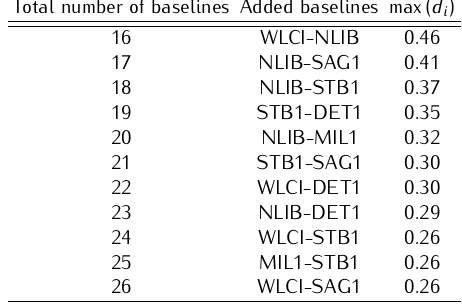
Figure 2. GPS Network (image from Google).